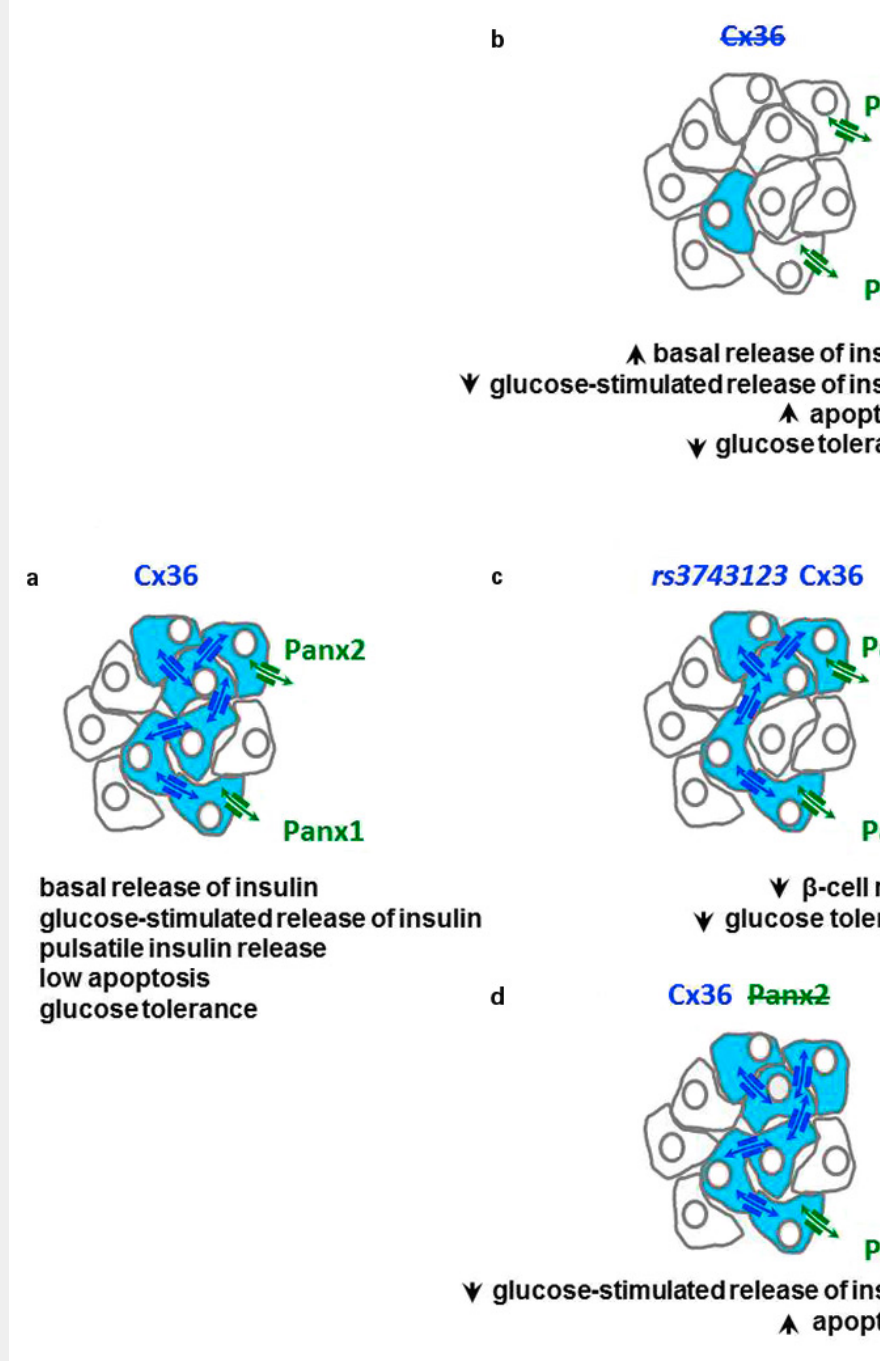
Figure 2 Cx36 and the insulin-producing β-cells. (a) The most abundant endocrine cell type of pancreatic islets, named β-cells, are only coupled by Cx36 channels, and also express Panx2 and Panx1. (b ) Loss of Cx36 increases (upward arrow heads) or decreases (downward arrow heads) the major characteristics of β-cells (Cx36-coupled cells are shown in blue), notably insulin secretion and apoptosis. (c ) These alterations are also observed in rodents and humans when β-cells express the rs3743123 variant of Cx36.The β-cell changes observed under such conditions mimic the major defects of type 2 and type 1 diabetes. In vitro , cells expressing this Cx36 variant are less coupled than cells expressing comparable levels of the wild type Cx36 form. (d ) Loss of Panx2 also results in a decrease of glucose-stimulated insulin secretion and in an increase of β-cell apoptosis. Reverse transcriptase-polymerase chain reaction analysis indicates that Panx2 and Panx1 may be co-expressed with Cx36 by individual β-cells, although a validation of this tentative conclusion awaits the development of fully specific antibodies against the two pannexin